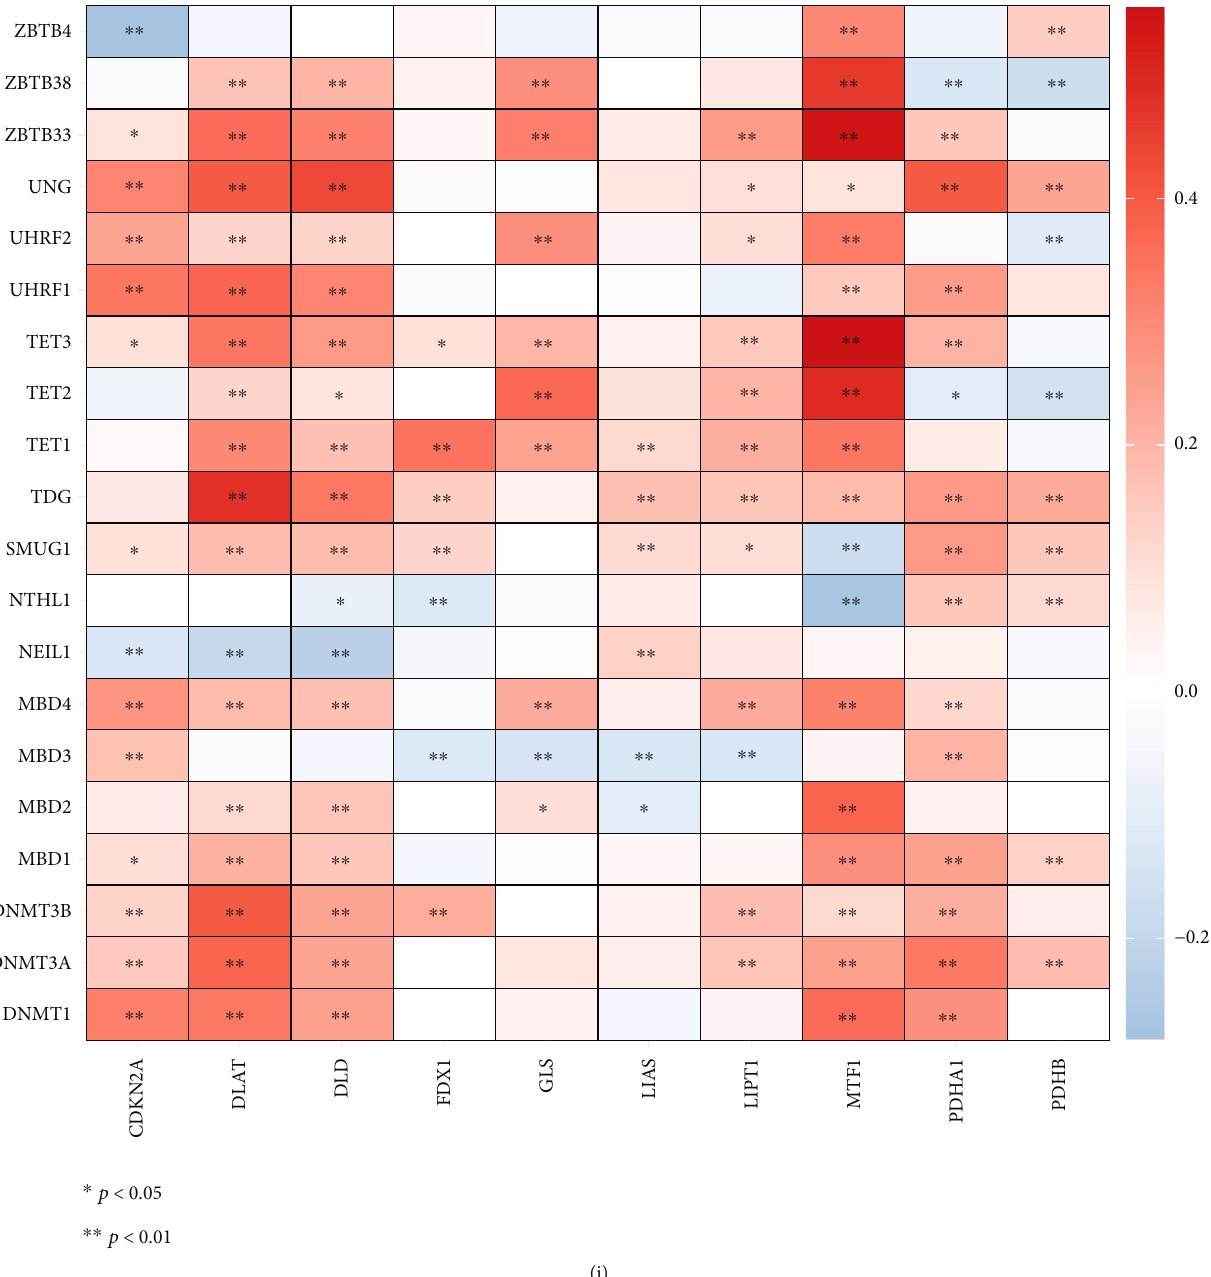
Figure 1: Landscape of transcriptional, genetic, and epitranscriptomic features and prognostic signi fi cance of cuproptosis genes across LUAD. (a) Heatmap visualizing the transcriptional levels of cuproptosis genes across normal and LUAD tissues. (b) Forest diagram for the univariate-cox regression results of cuproptosis genes with LUAD patients ’ OS. (c) Pearson ’ s correlations between cuproptosis genes at the transcriptional levels. (d) Associations between proteins from cuproptosis genes through the STRING website. (e) Waterfall plot depicting the mutation events of cuproptosis genes across individual LUAD patients. Statistical plots of mutation events for each gene are displayed in the right panel. Variant classi fi cations are marked by unique colors. (f) Bar chart for the CNV frequency of cuproptosis genes. Blue and red circles denote arm-level CNV gains and losses, respectively. (g – i) Heatmaps showing the interactions of m6A, m1A, and m5C modi fi ers with cuproptosis genes across LUAD. ∗ p < 0 : 05 ; ∗∗ p < 0 : 01